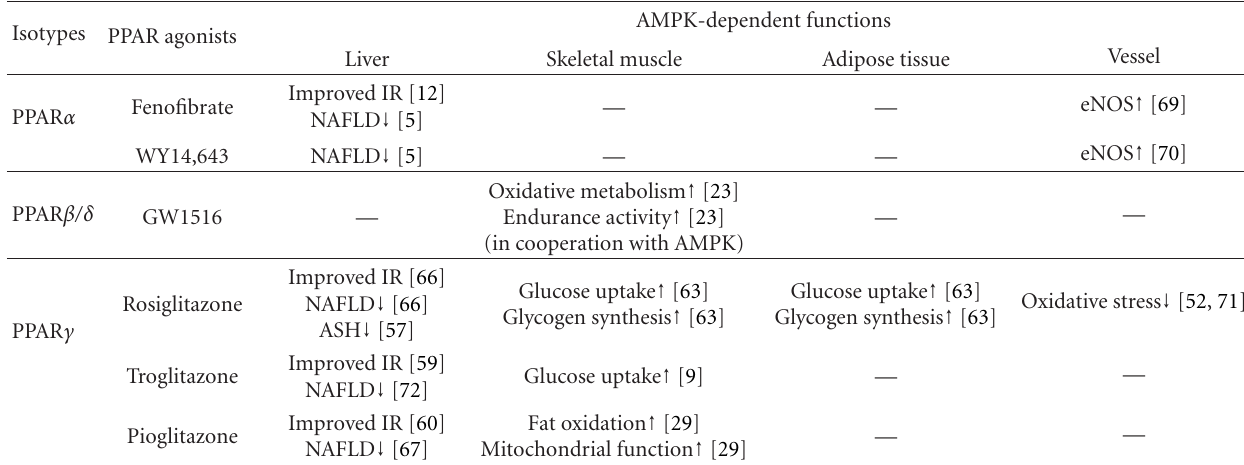
Table 1: The e ff ects of PPAR agonists on AMPK-dependent metabolic functions. Isotypes PPAR